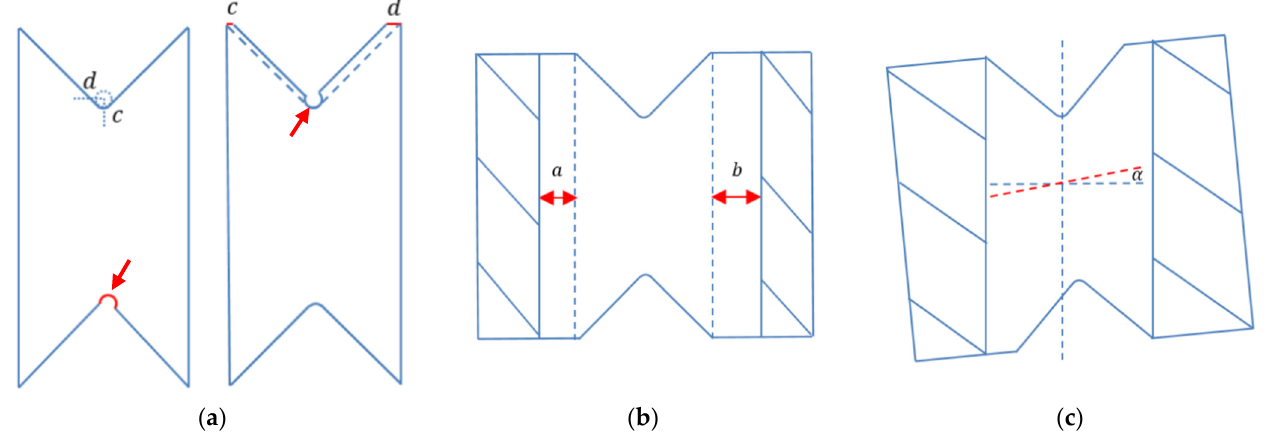
Figure 24. ( a , b ) Possible sources that may be affecting the shear stress value; ( a ) defect in the notch radius (marked by arrows); ( b ) asymmetrical gripping, a ≠ b; ( c ) deviation from the load line marked by the angle α . Table 9. Shear values for different radius profile and